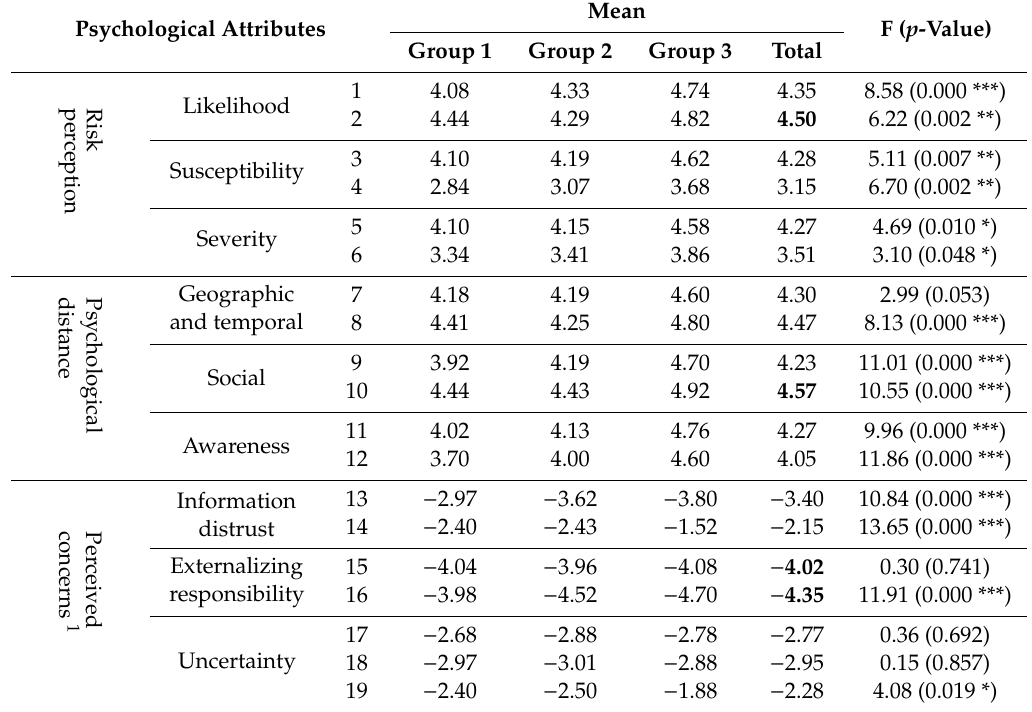
Table 11. Psychological influences on residents’ response